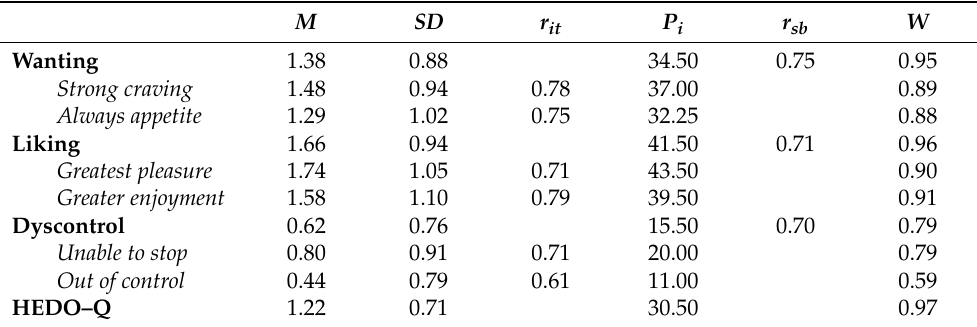
Table 2. Descriptions and item characteristics of the Hedonic Overeating–Questionnaire (HEDO–Q) ( N = 2531).